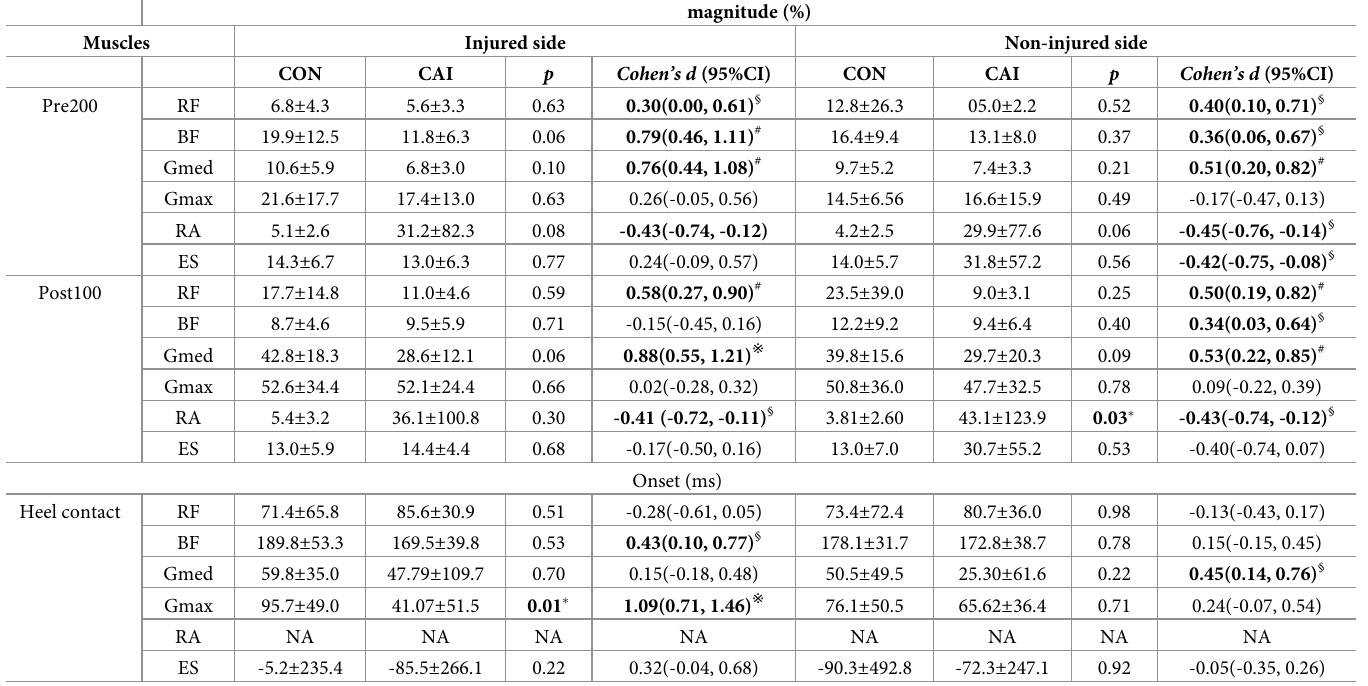
Table 1. Group means, Cohen’s d effect size, and group difference for the magnitude and onset of muscle activation in the unperturbed walking trail. magnitude (%) Muscles Injured side Non-injured side